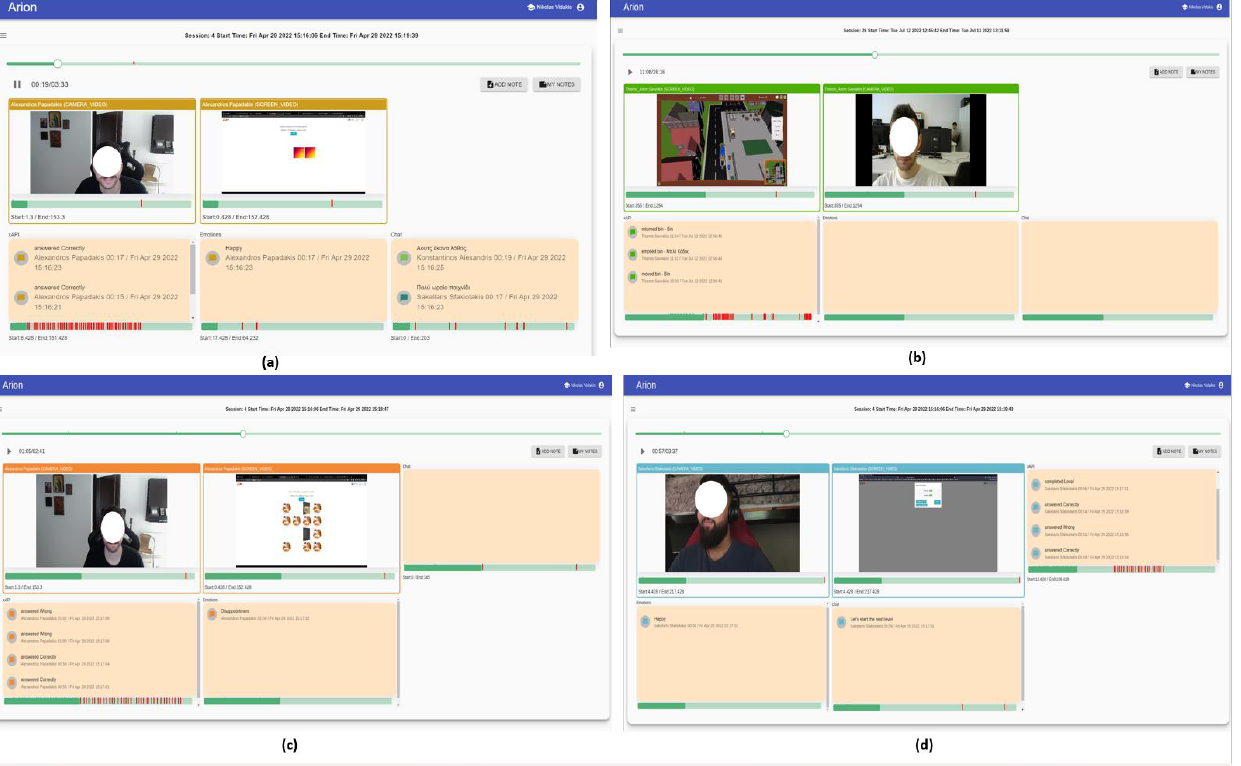
Figure 13. Learner Evaluation with multimodal Data Validation. ( a ) Arion Evaluation Session for learner “A.Papadakis” happy; ( b ) Arion Evaluation Session for learner “T.Savvakis”; ( c ) Arion Eval- uation Session for learner “A.Papadakis” disappointed; ( d ) Arion Evaluation Session for learner